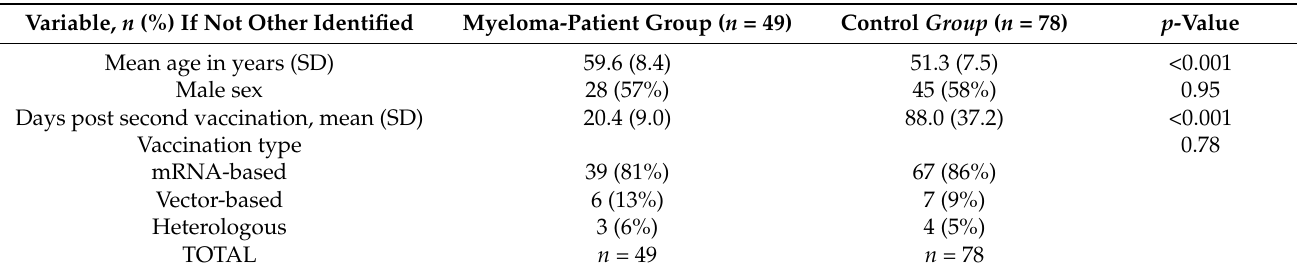
Table 4. Demographics and characteristics of myeloma-patient subgroup and control group ( ≤ 70 years); SD, standard